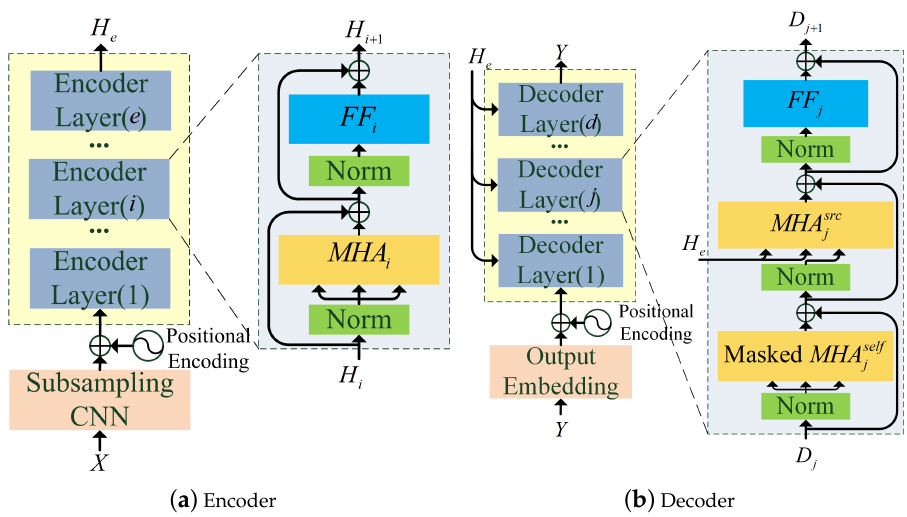
Figure 1. Encoder and